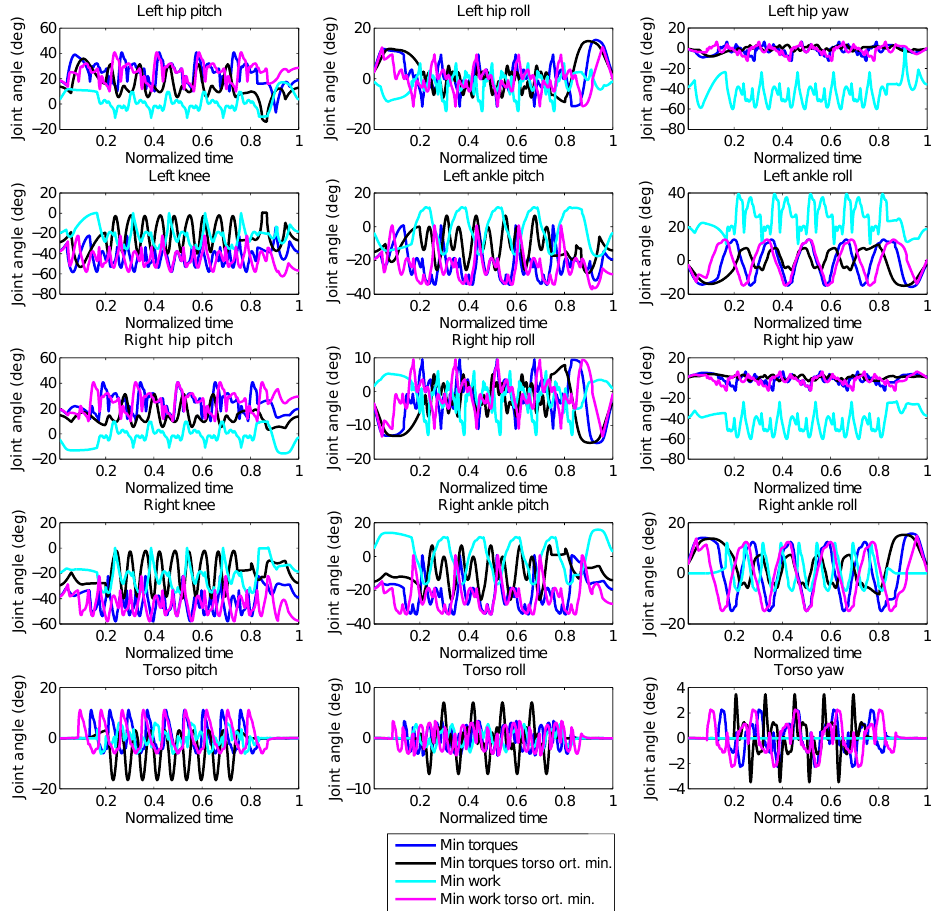
Figure 8. Joint angle trajectories of all the 15 DOF of the robot, obtained for the four combinations of objective functions. Time is normalized for all trajectories for comparison purposes. It is to be noted that torso orientation minimization does not mean reduction of the movements of the torso joints, but the orientation w.r.t. the world